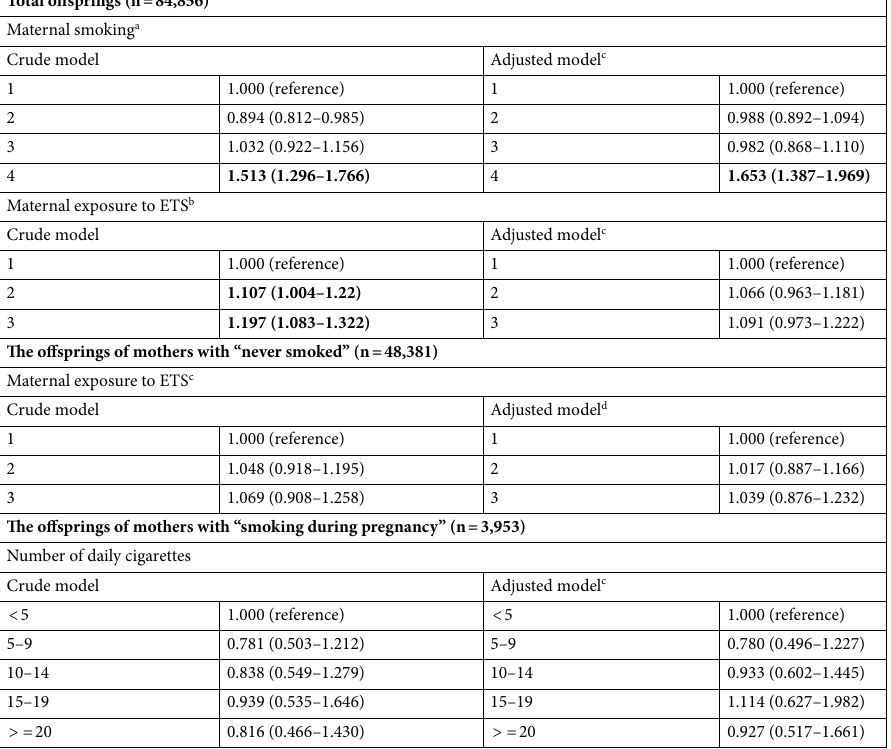
Abruptio placentae aOR (95%